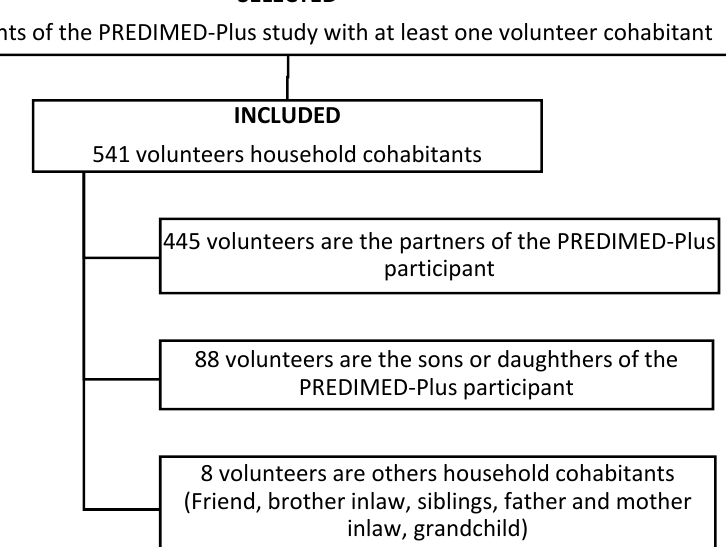
Table 1. General characteristics of the household PREDIMED ‐ Plus cohabitants.